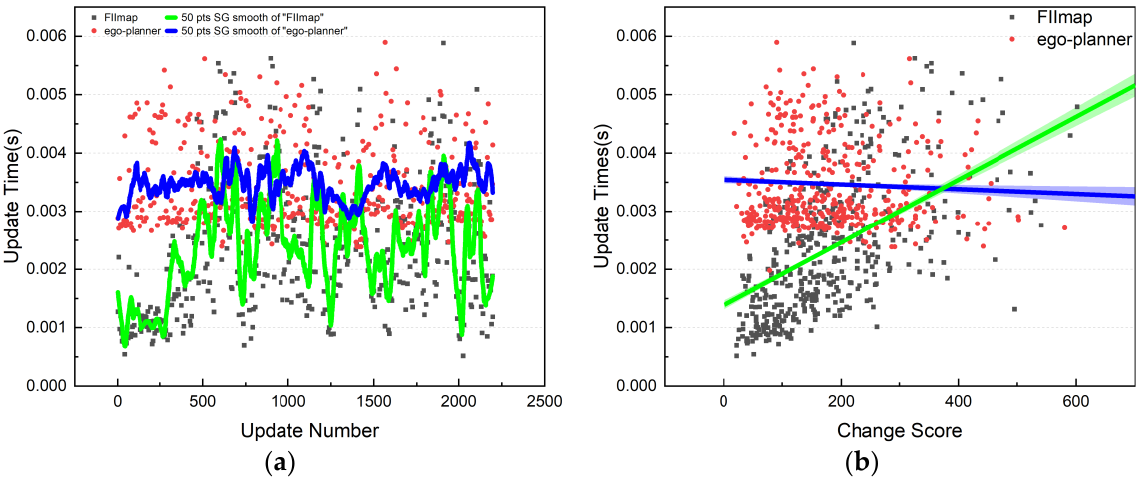
Figure 8. Comparison of the laboratory corridor dataset. The resolution is 0.2 m and the inflated size is double voxel resolution. The update number axis means the time axis. ( a ) The time consumption with update number. ( b ) The time consumption with change